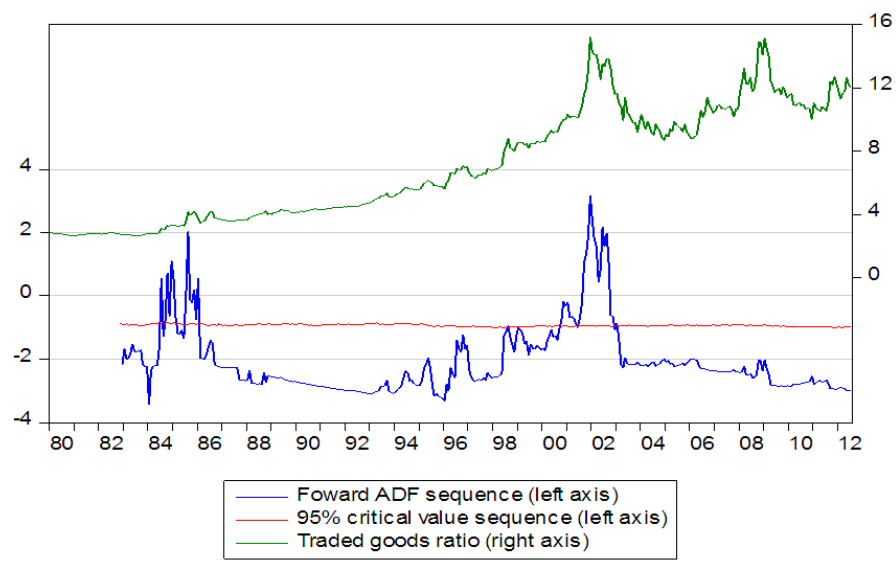
Fig. 3. SADF test for real exchange rate of traded